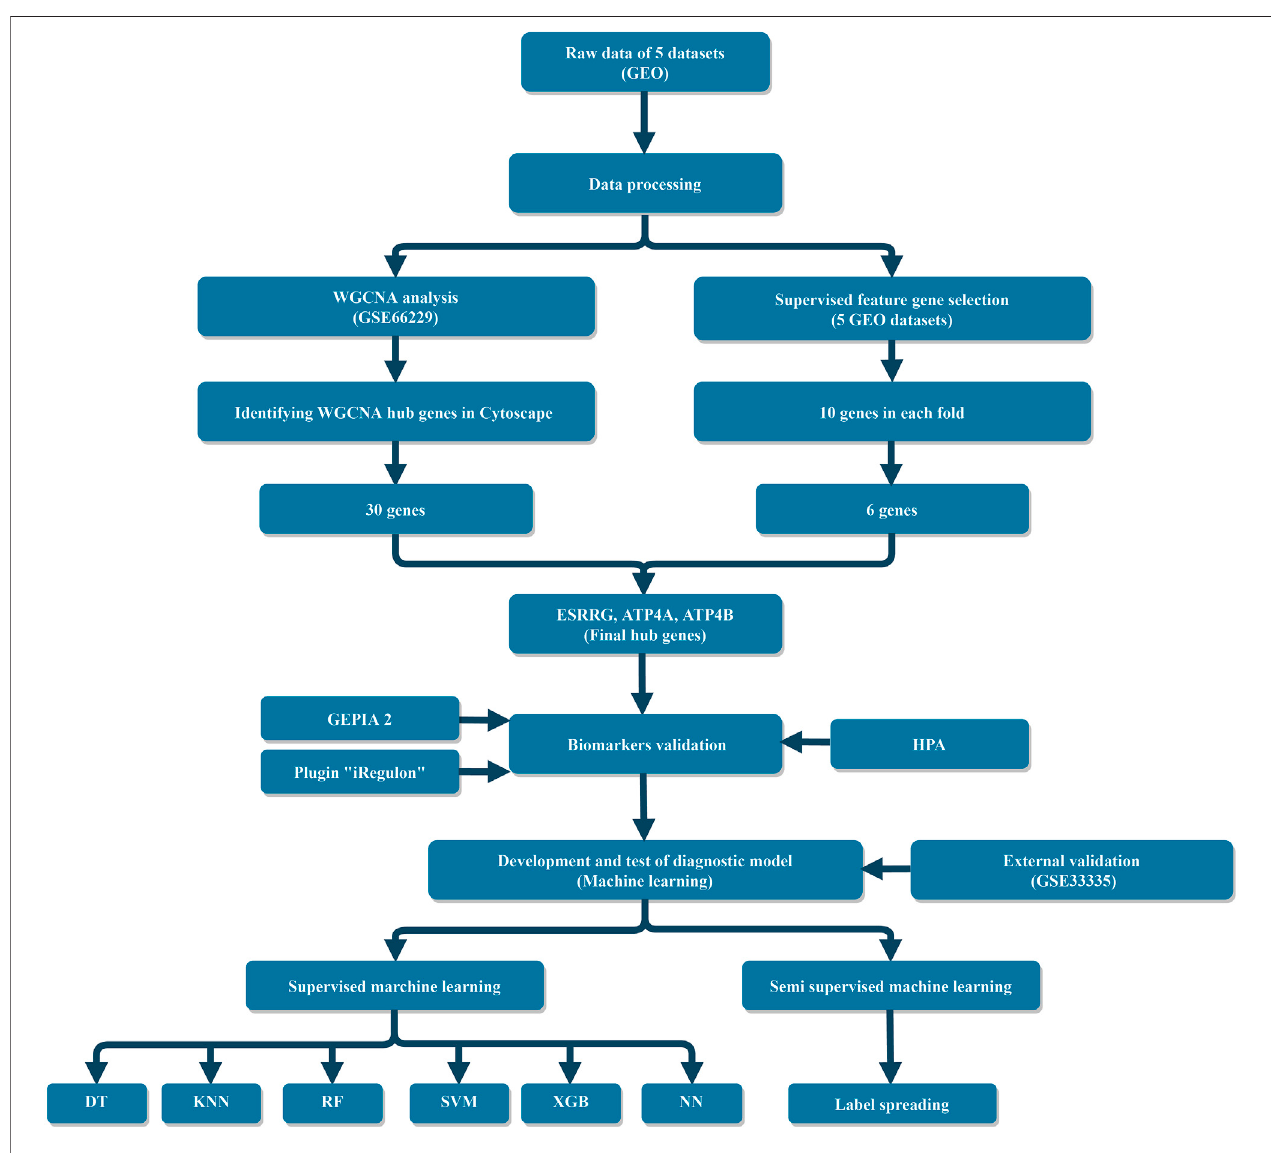
FIGURE 1 | Flowchart of this